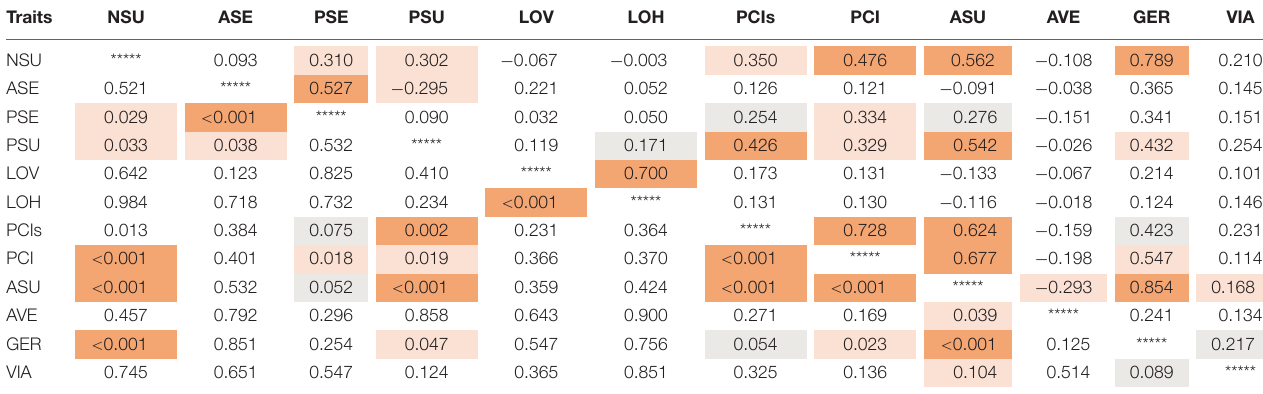
TABLE 4 | Correlation values (above diagonal) and corresponding significance ( p -values, below diagonal) for seed traits measured on 56 genotypes of purple passion fruit ( Passiflora edulis f. edulis Sims). Traits NSU ASE PSE PSU